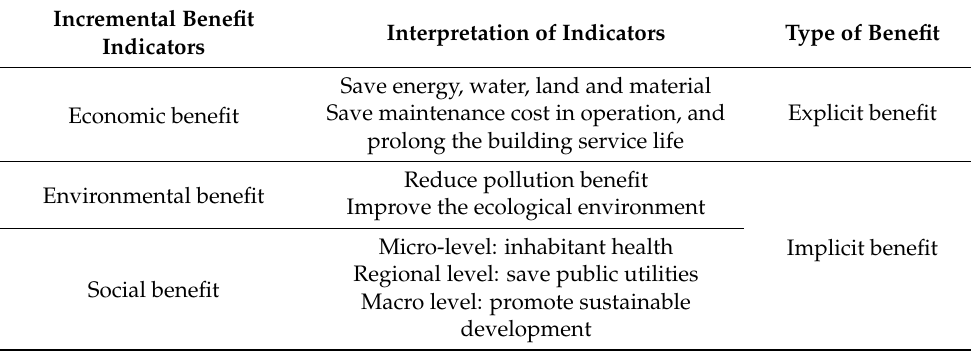
Table 2. Index Constitution of Green Building Incremental